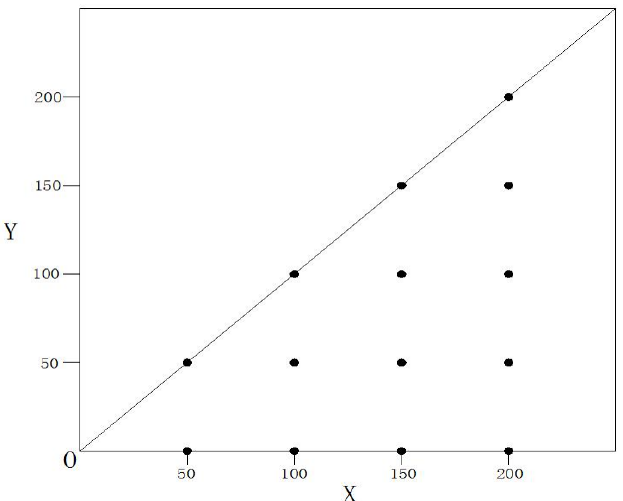
Figure 2. Distribution of sampling points in the X-Y